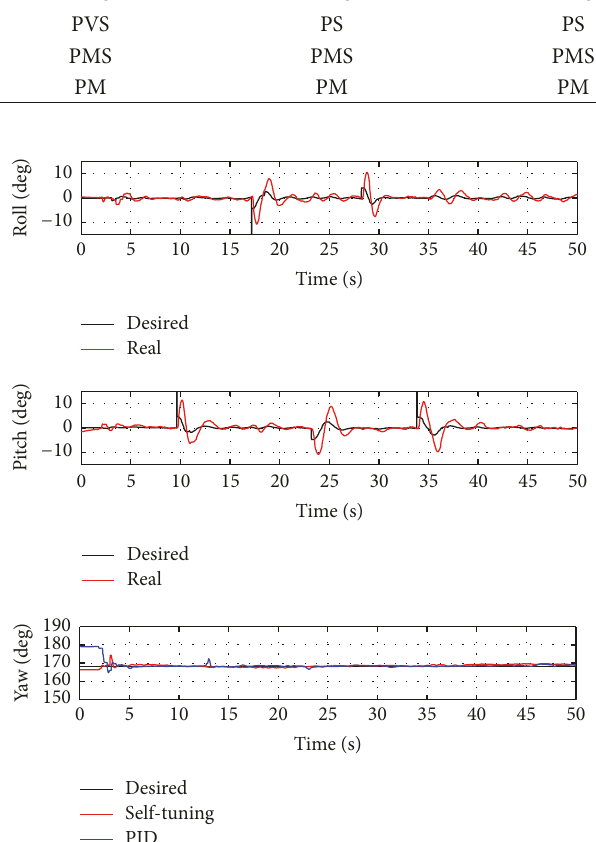
Figure 20: Response curves of quadrotor UAV attitude (𝜙,𝜃, 𝜓)